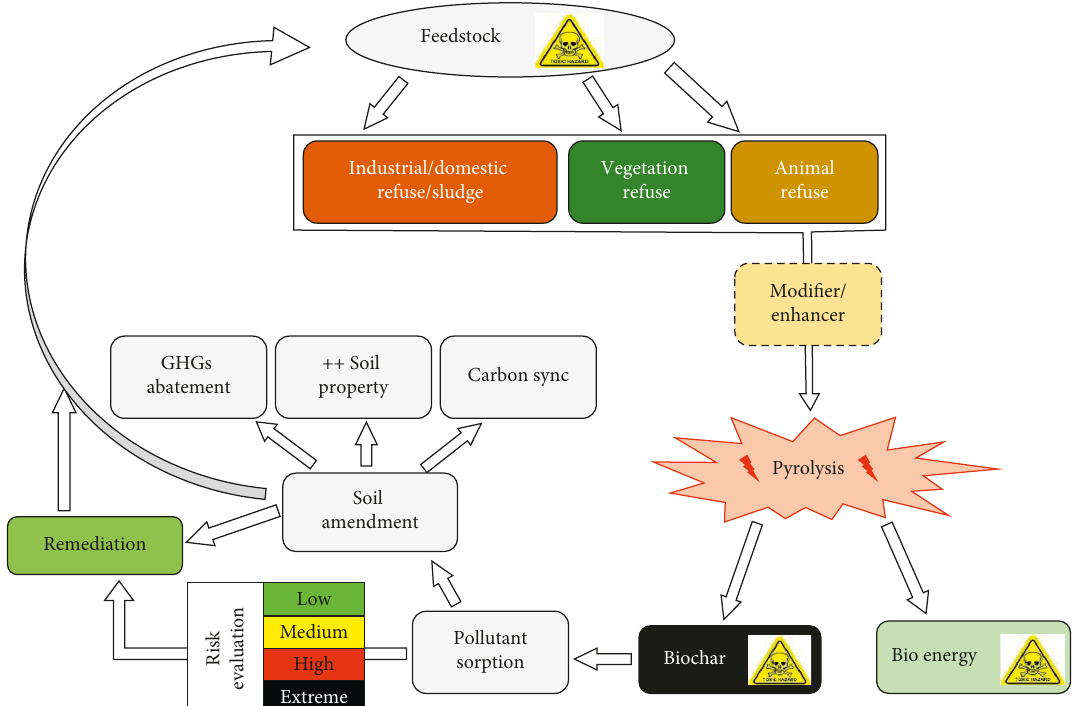
Figure 1: Feedstock recycling, pyrolysis, biochar, and